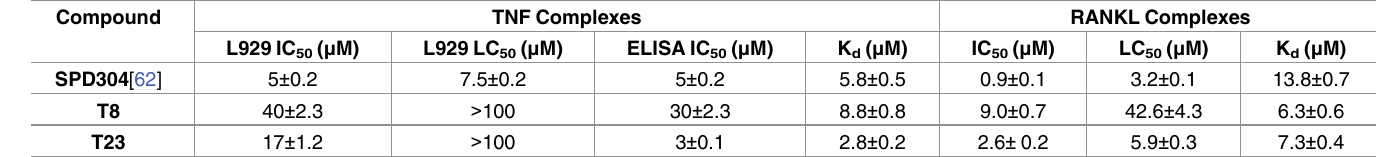
Table 4. Inhibition, toxicity and binding evaluation of SPD304, T8 and T23 in TNF and RANKL complexes. Compound